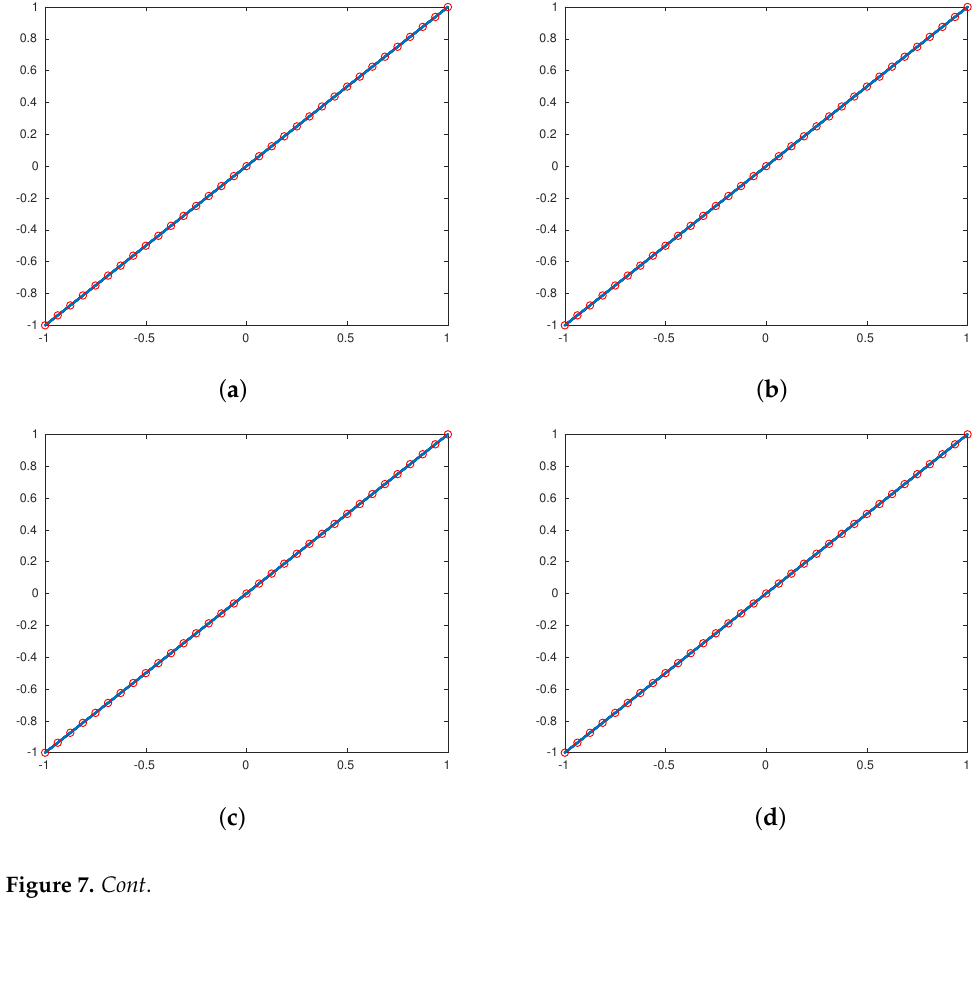
. In this figure, the original sampling is 3